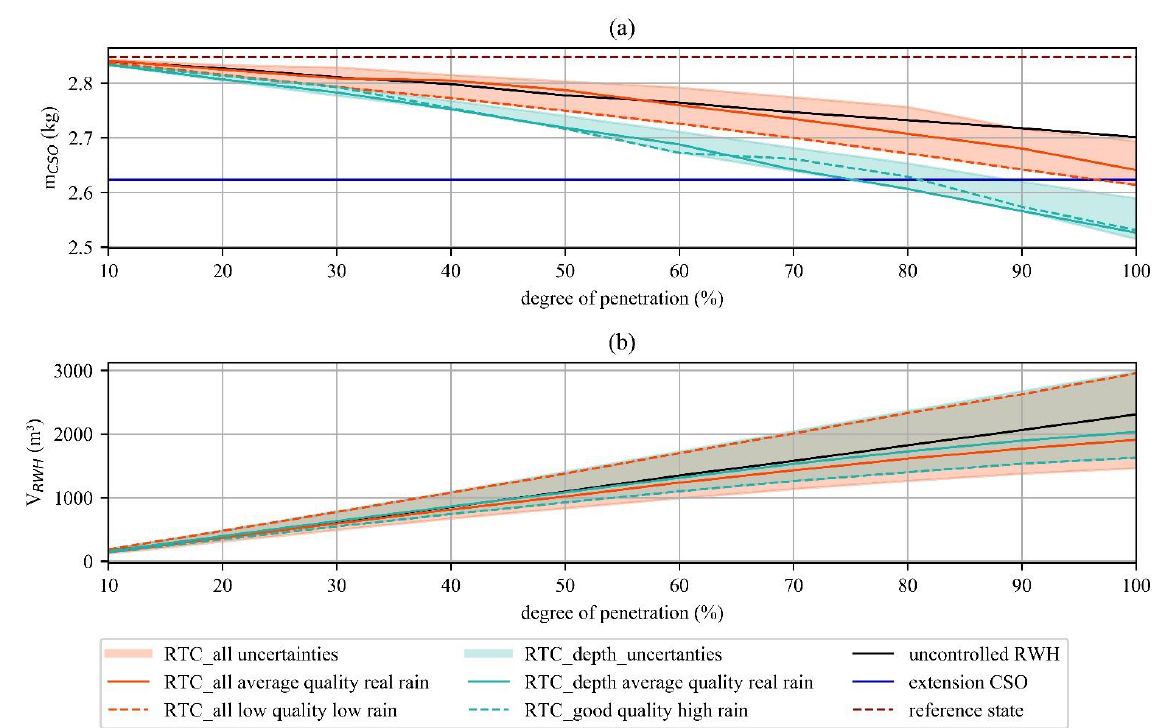
Figure 4. Performance evaluation based on ( a ) m CSO and ( b ) V RWH resulting from control strategies ‘RTC all’ and ‘RTC CSO depth’ and compared with uncontrolled RWH systems for different degrees of penetration. Additionally, the range of digital uncertainties associated with any kind of RWH systems is highlighted.